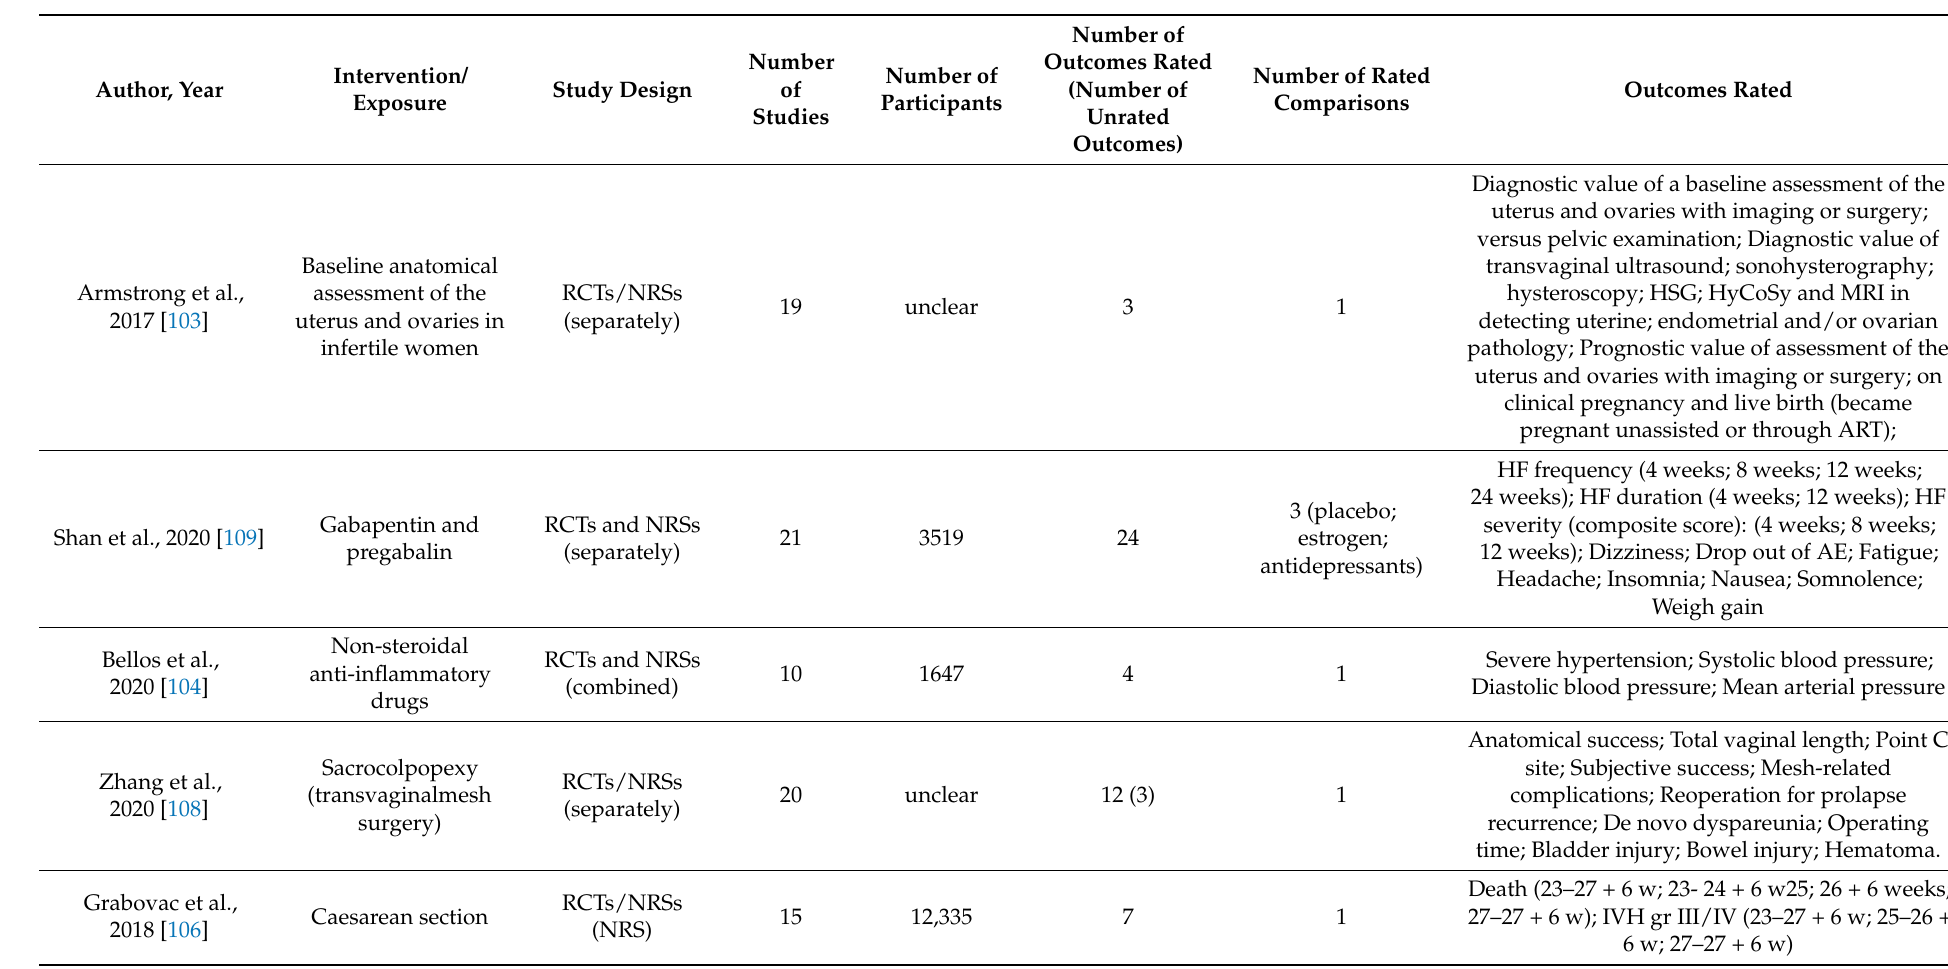
Table 4. Summary of the study characteristics and the number and type of (un)rated outcomes of systematic reviews of RCTs/NRSs ( n = 8) that rated the outcome-specific certainty of evidence with